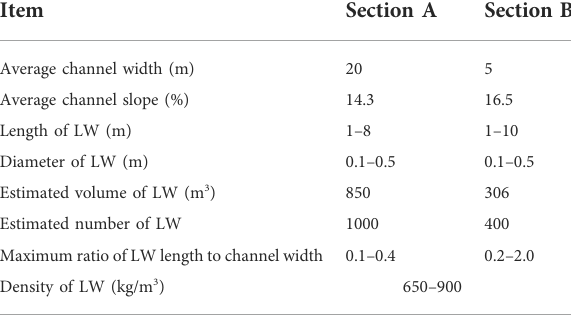
TABLE 1 Statistical data of LW parameters in Qipangou, Wenchuan County on 11 July